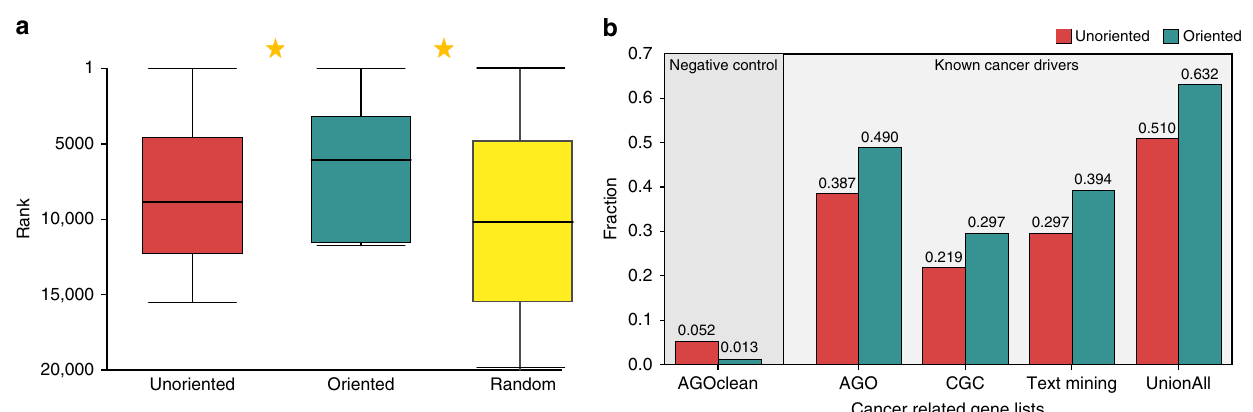
Fig. 5 Orientation improves the prediction of drug targets and cancer driver genes. a The genes in the network are ranked according to their proximity to the differentially expressed genes of a given drug. We calculated the rank assigned to the correct drug targets by using the oriented network versus the unoriented one and a random ranking, and found that the oriented-based scoring ranks the correct drug targets higher (closer to 1) than both the unoriented-based scoring and the random scoring, with Kalgarov-Smirnov p -value < 0.05, indicated by a star. The box plots were plotted using seaborn python package with the default setting (as detailed before in Fig. 2c). b The genes in the network are ranked by their proximity to the differentially expressed genes of the cancer patients. Showing here the percentage of genes out of the top K = 1% ranked genes matching known driver genes and known non-driver from multiple sources for AML. The oriented network consistently reports more known driver genes and less known non-drover genes than the unoriented one, see extended results in Supplementary Fig. Methods Diffusion-based orientation . We devised an orientation algorithm, Diffuse2Direct (D2D), which is based on propagating signals from causal to affected proteins and observing the direction of signal fl ow in the network. Unlike previous approaches, the algorithm does not rely on shortest paths only and accounts for all possible paths from source to target proteins. D2D receives as input a collection of experiments inducing paired sets of causes and effects, and a network of physical